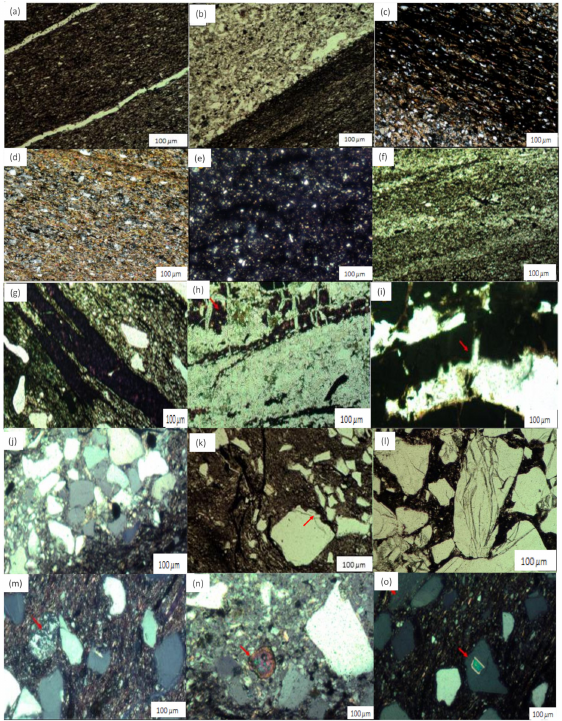
Figure 5. Thin section photomicrographs showing: ( a ) clay matrix and quartz vein in shale; ( b ) clay and silt size particles in shale; ( c ) alignment of mineral grains parallel to the lamination planes in shale; ( d ) clay minerals and silt size quartz grains in shale; ( e , f ) clay matrix in mudstone; ( g ) hematite staining in mudstone; ( h ) pyrite in mudstone; ( i ) nodular pyrite in shale; ( j )silt and sand size particles (sandstone); ( k ) quartz overgrowth in clay matrix; ( l ) fractured feldspar grains; ( m ) quartz and metamorphic lithic (quartzite) in clay matrix; ( n ) heavy mineral (zircon) in clay matrix; ( o ) mineral inclusion (mica) in